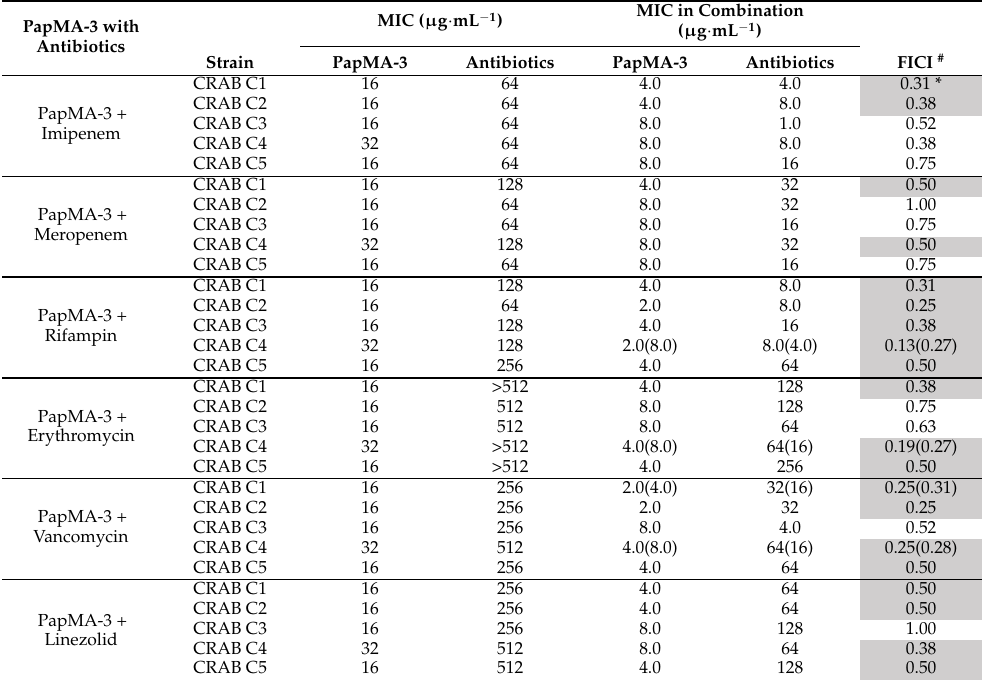
Table 3. FICI for the synergistic effect of PapMA-3 in combination with antibiotics against CRABs. PapMA-3 with